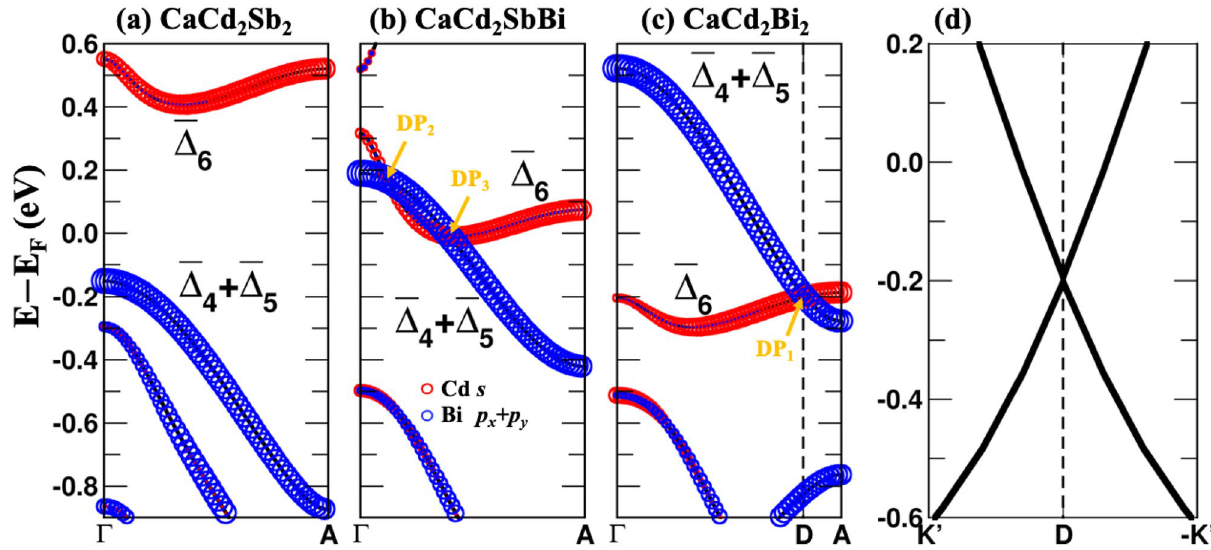
Figure 3. ( a – c ) The HSE06 with SOC band structures of CaCd 2 Sb 2 , CaCd 2 SbBi, and CaCd 2 Bi 2 . The circle corresponds to the orbital contribution from Cd s orbital and Bi p x and p y orbitals indicated by red and blue, respectively. The irreducible representations are labeled as (cid:31) 6 and (cid:31) 4 + (cid:31) 5 . The three Dirac points are labeled in orange arrows (DP 1 , DP 2 , and DP 3 ). ( d ) Zoomed-in view of the band path near passing the Dirac cone of CaCd 2 Bi 2 along the -K’ to D to